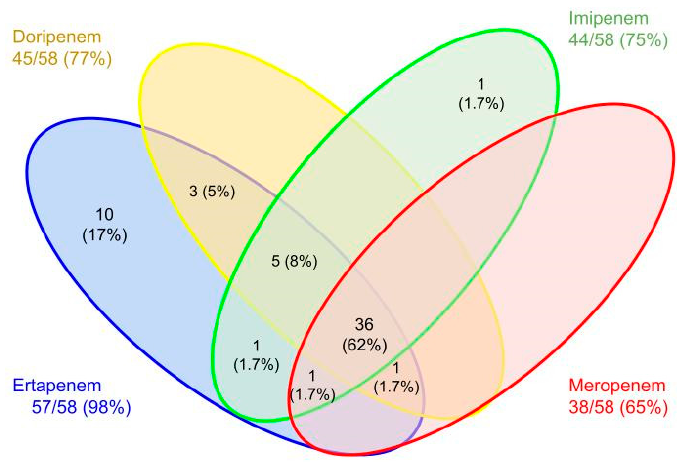
Figure 1. Carbapenem resistance distribution in Enterobacterales.